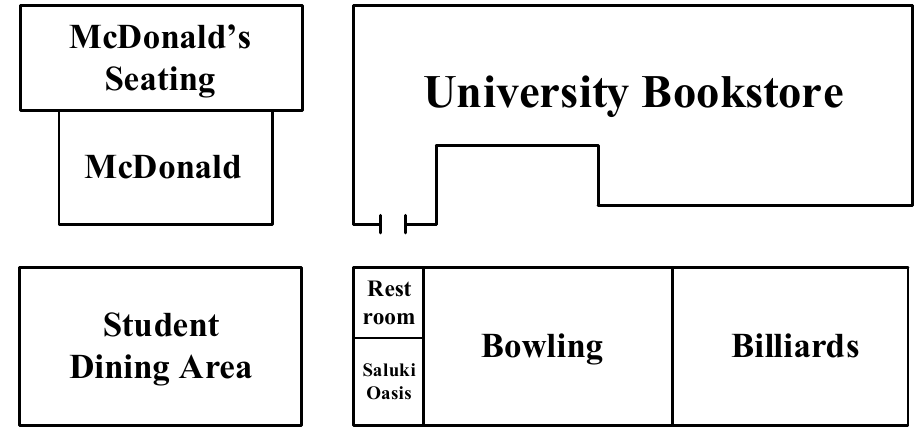
Figure 5. Floor plan of simulated university bookstore and its neighboring stores.